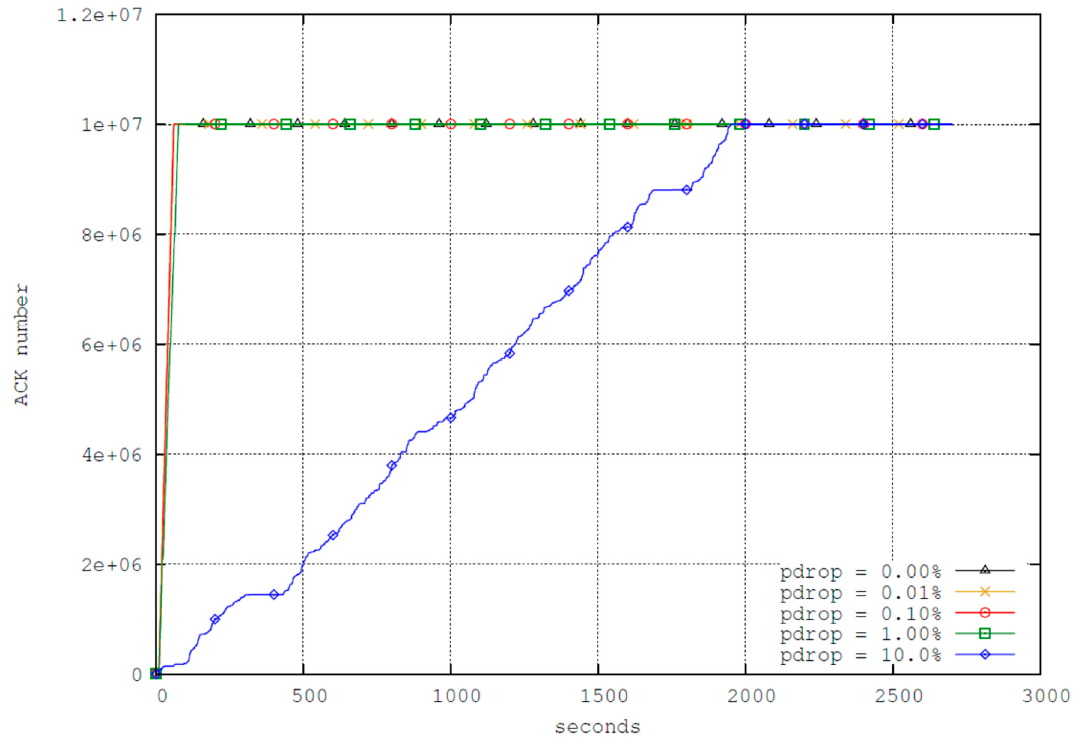
Figure 4. TCP Sent Segment ACK Number ( FTP Client) over 2700 s of simulation time.